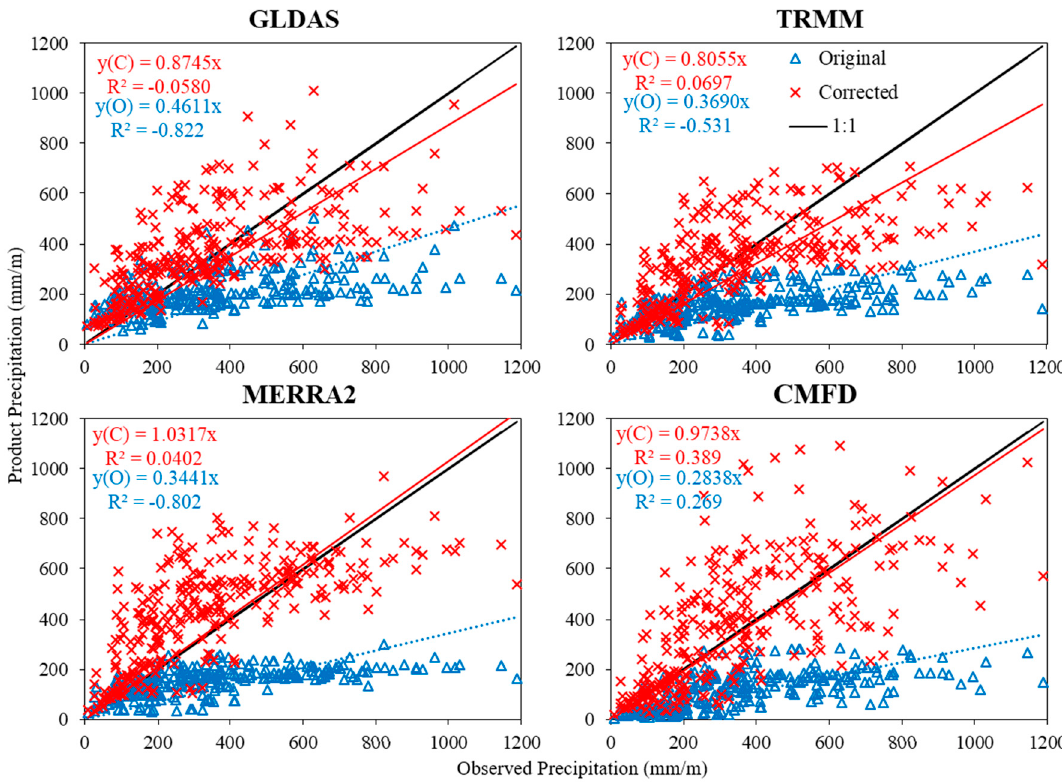
Figure 8. Comparison of the original and corrected monthly precipitation from four products at all stations.